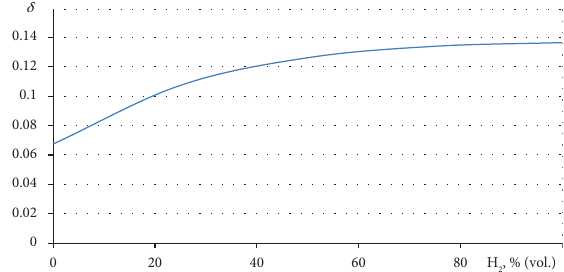
Figure 13: Dependence of the overall nonuniformity of the temperature feld at the combustion chamber’s outlet for diferent volume content of hydrogen in the